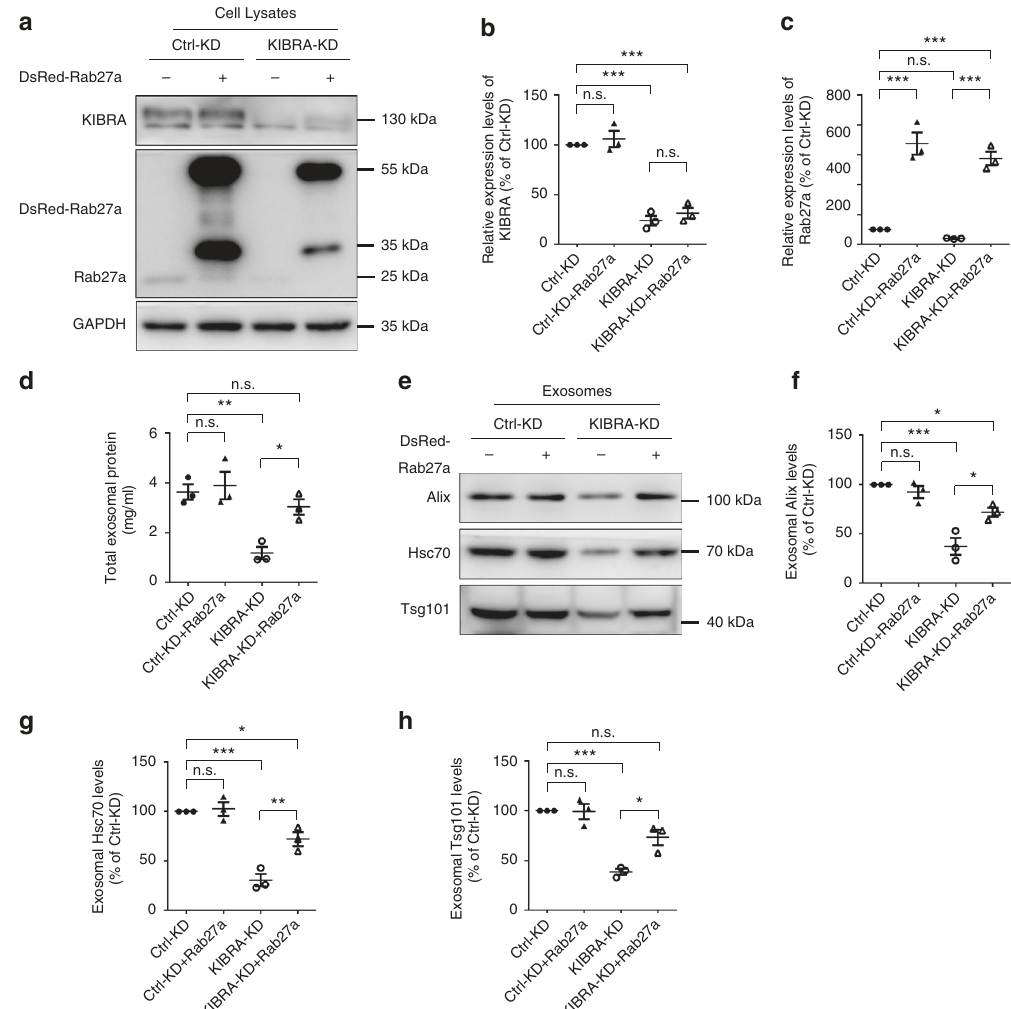
Fig. 6 Overexpression of Rab27a rescues the impaired exosome secretion induced by depleting KIBRA. a Western blot was performed to determine the protein levels of KIBRA and Rab27a in KIBRA-KD and Ctrl-KD cells transfected with plasmids encoding Rab27a or not. b , c Quanti fi cation of KIBRA ( b ) and Rab27a ( c ) levels in three independent experiments. d Concentration of exosomal proteins in KIBRA-KD and Ctrl-KD cells transfected with DsRed-Rab27a or not. e Western blot analysis of extracellular vesicles puri fi ed from equal numbers of KIBRA-KD and Ctrl-KD cells transfected with plasmids encoding Rab27a or not. f – h Quanti fi cation of Alix ( f ), Hsc70 ( g ), and Tsg101 ( h ) levels in three independent experiments. The quanti fi cation results were plotted as dot plots, showing the mean ± SE. * P < 0.05, ** P < 0.01, *** P < 0.001. n.s., not signi fi cant ( P > 0.05) as determined by the one-way analysis of variance